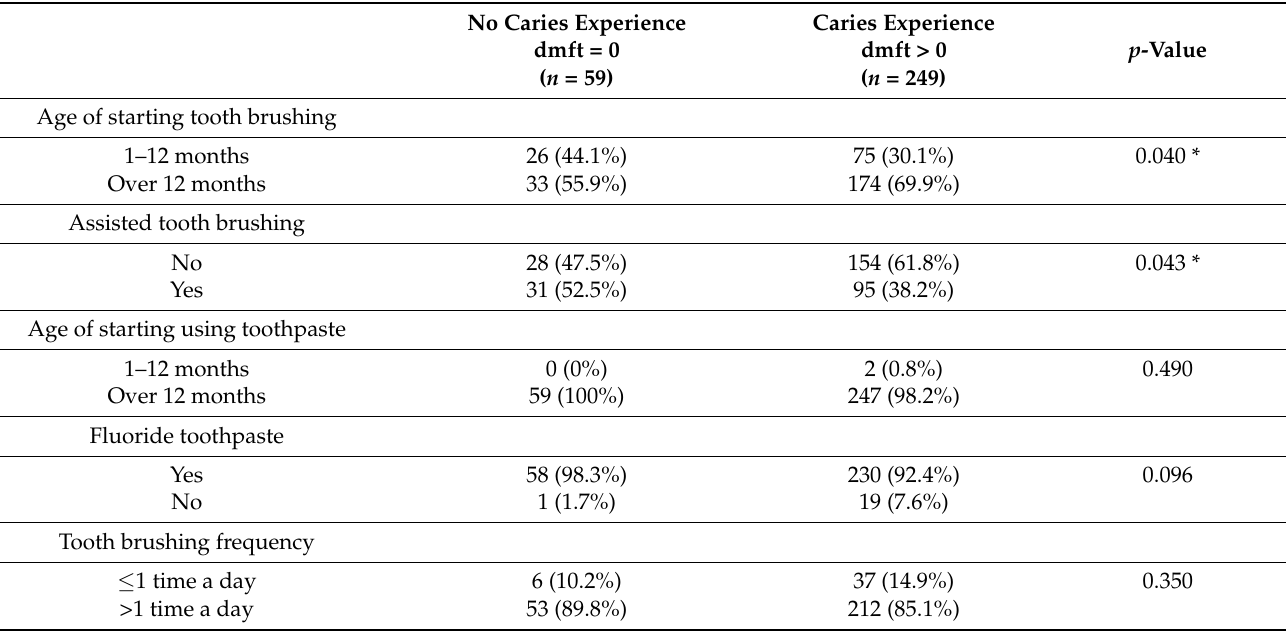
Table 3. Oral health-related behaviors of children with and without caries